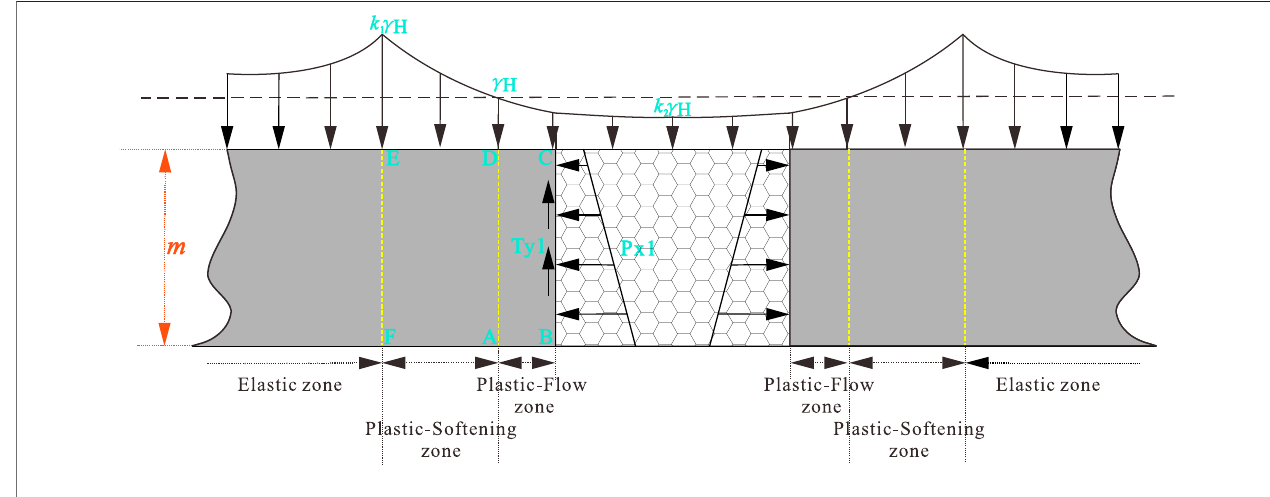
FIGURE 3 | Schematic diagram of the mechanical model during roof connection (single-side goaf model).